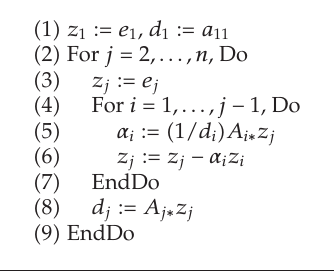
Algorithm 2: Left-looking AINV algorithm without